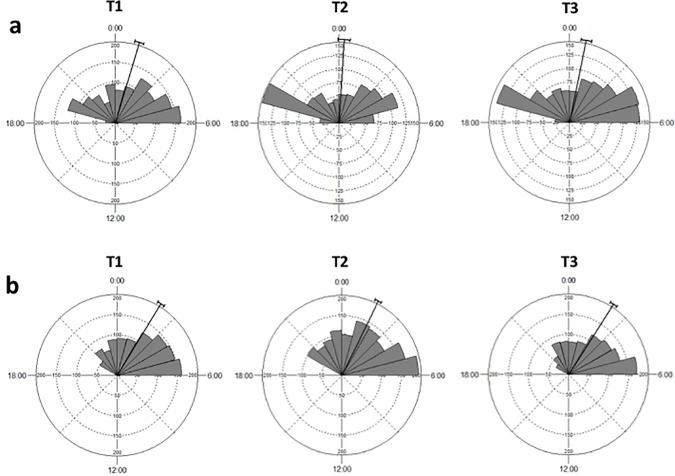
Diel activity patterns of deermice in each treatment (T).(a) samples from late winter, and (b) samples from spring. Bars indicate the proportion of independent records taken at that time of the day. Tick lines represent the mean vector and its circular standard deviation.